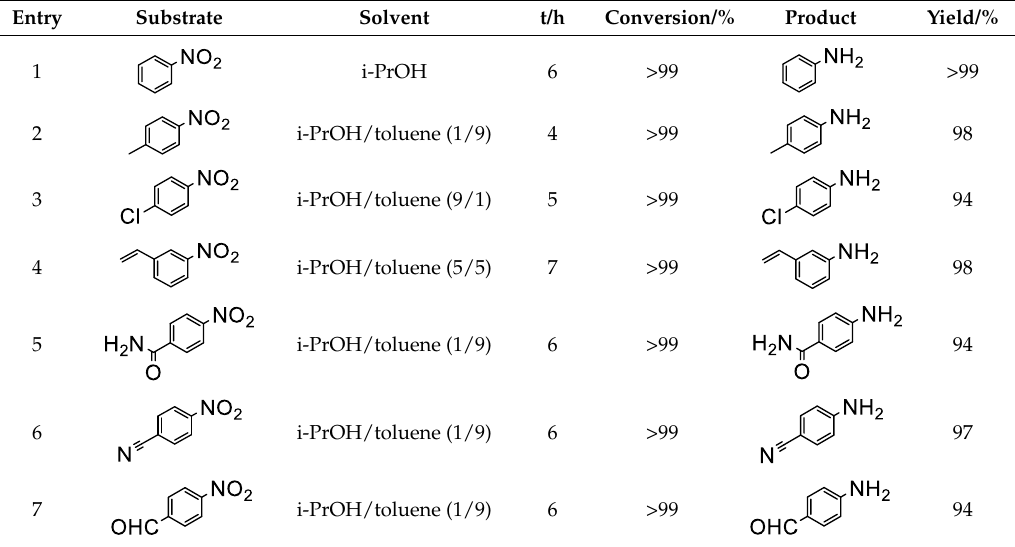
Table 1. Rutile-TiO 2 photocatalytic transfer hydrogenation of nitrobenzenes with i-propanol. Entry